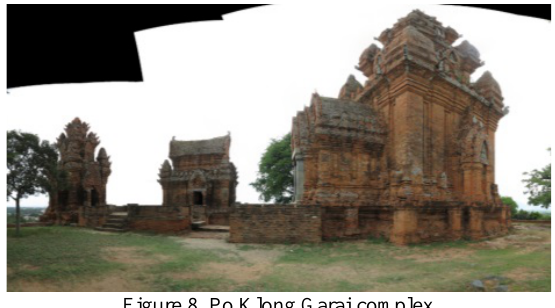
Figure 8. Po Klong Garai